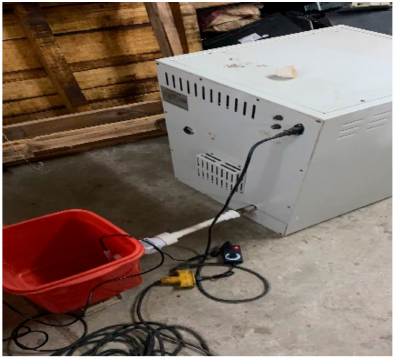
Figure 7. Schematic diagram of installing fan on vent.